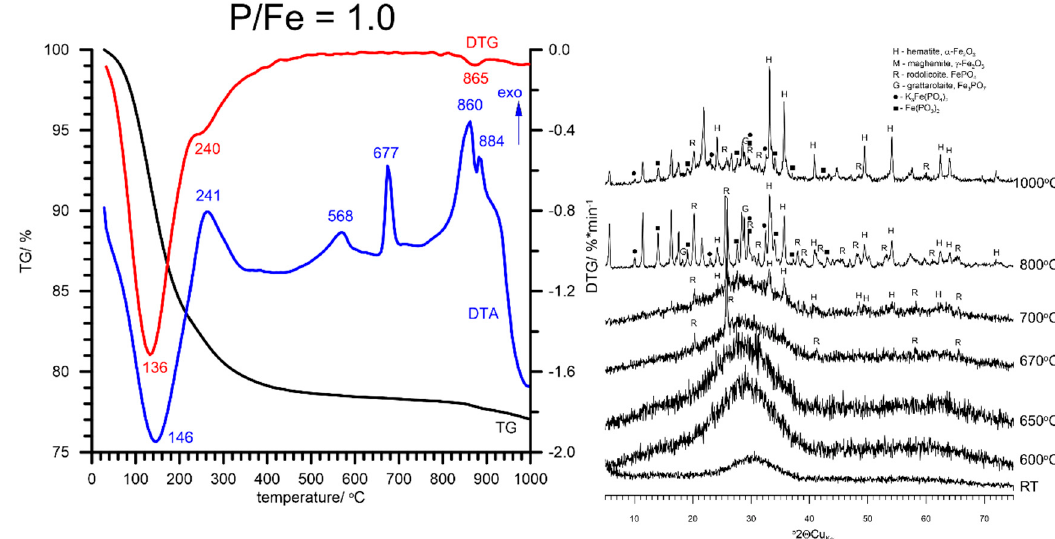
Figure 7. The results of thermal analysis and XRD patterns of P-doped synthetic ferrihydrite at the high P / Fe molar ratio of 1. Rodolicoite, which appears above 650 ◦ C, is stable up to 1000 ◦ C. This is associated with the formation of grattarolaite Fe 3 PO 7 and other Fe-phosphates above 800 ◦ C. All these phases, possibly partially precipitated from the melt, remain stable up to 1000 ◦ C.